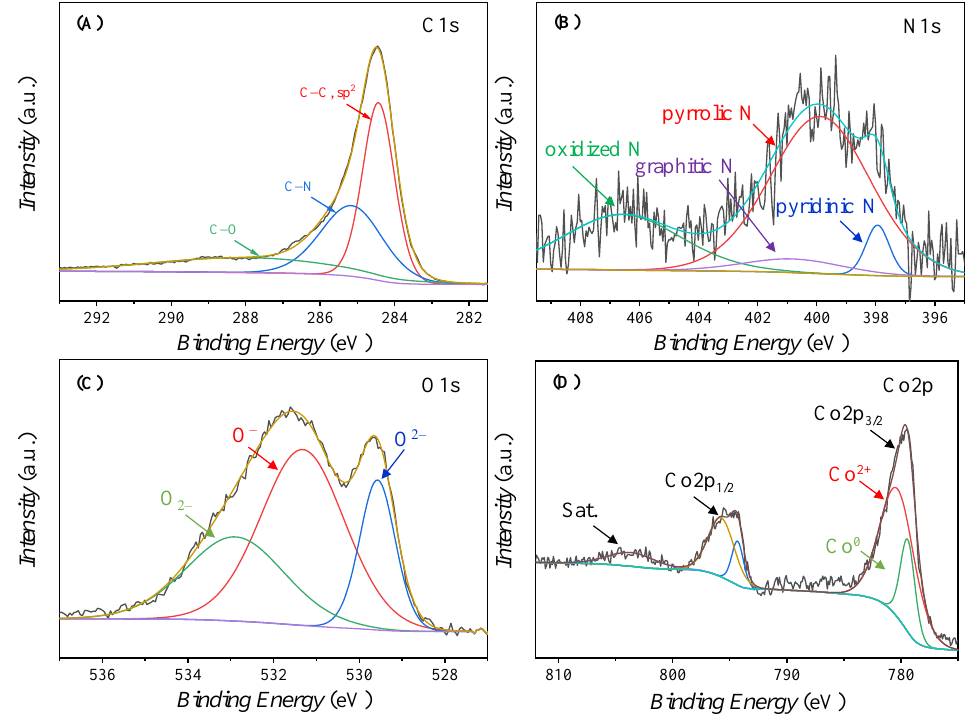
Figure 5. High-resolution XPS spectra of Co/CoO@NCS, ( A ) C1s, ( B ) N1s, ( C ) O1s, and ( D ) Co2p.